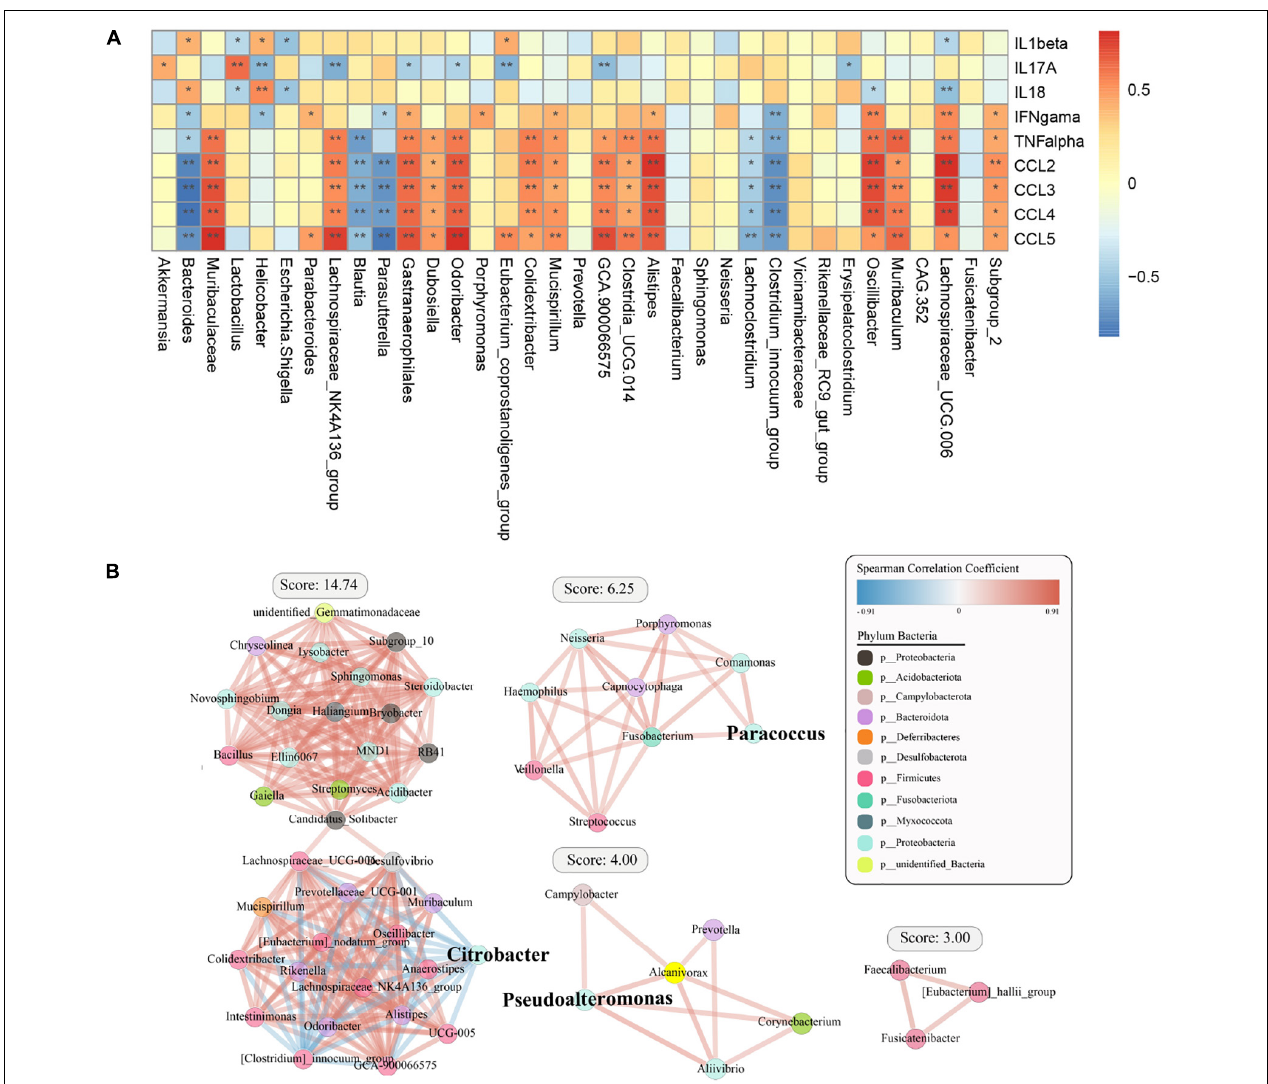
FIGURE 6 | Spearman correlation analysis between specific or differential microbial taxa and infection-related indicators among the four groups. The shade of the resulting color is closely related to the value of the Spearman correlation coefficient ( ∗ p < 0.05, ∗∗ p < 0.01, indicates a significant finding after correction for the false discovery rate). (A) The red and blue colors indicate positive and negative correlations in the relative abundance, respectively. (B) Correlation coefficient between the dominant bacterial phyla in the different